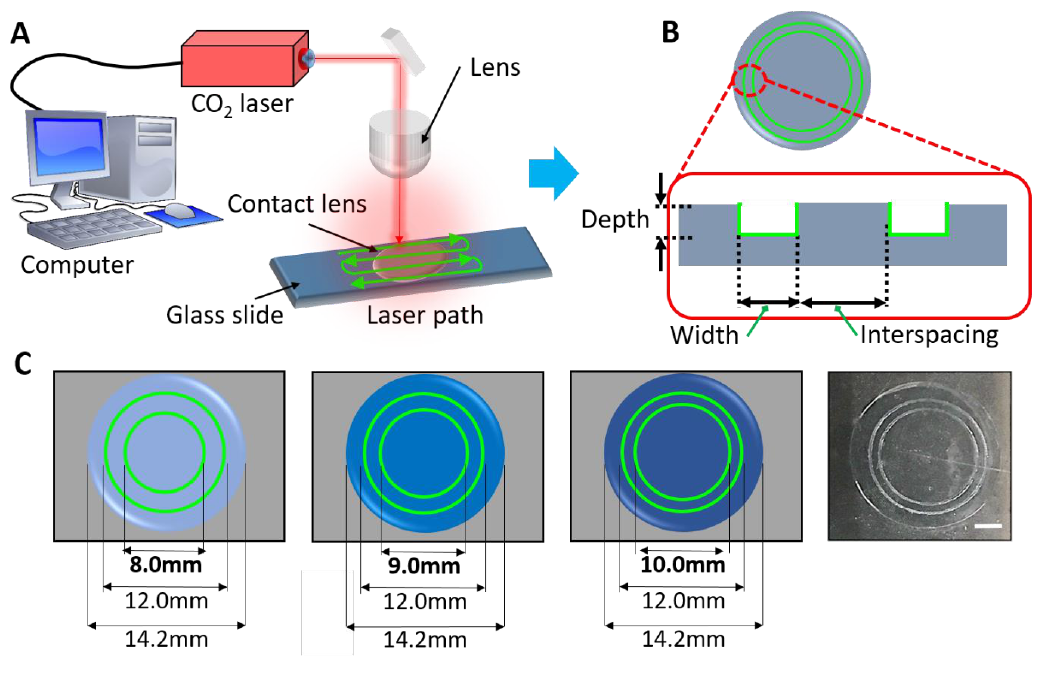
Figure 1. Fabrication of concentric rings on contact lenses. ( A ) Schematic of the laser setup; ( B ) Illustration of the top and side views of the contact lens after the laser-treatment; ( C ) Geometrical features of the couple-rings with an interspace of 2 mm (for the couple-ring of diameters 8 and 12 mm), 1.5 mm (for the couple-ring of diameters 9 and 12 mm), and 1 mm (for the couple-ring of diameters 10 and 12 mm), and a photograph of the processed contact lens, scale bar 3 mm.